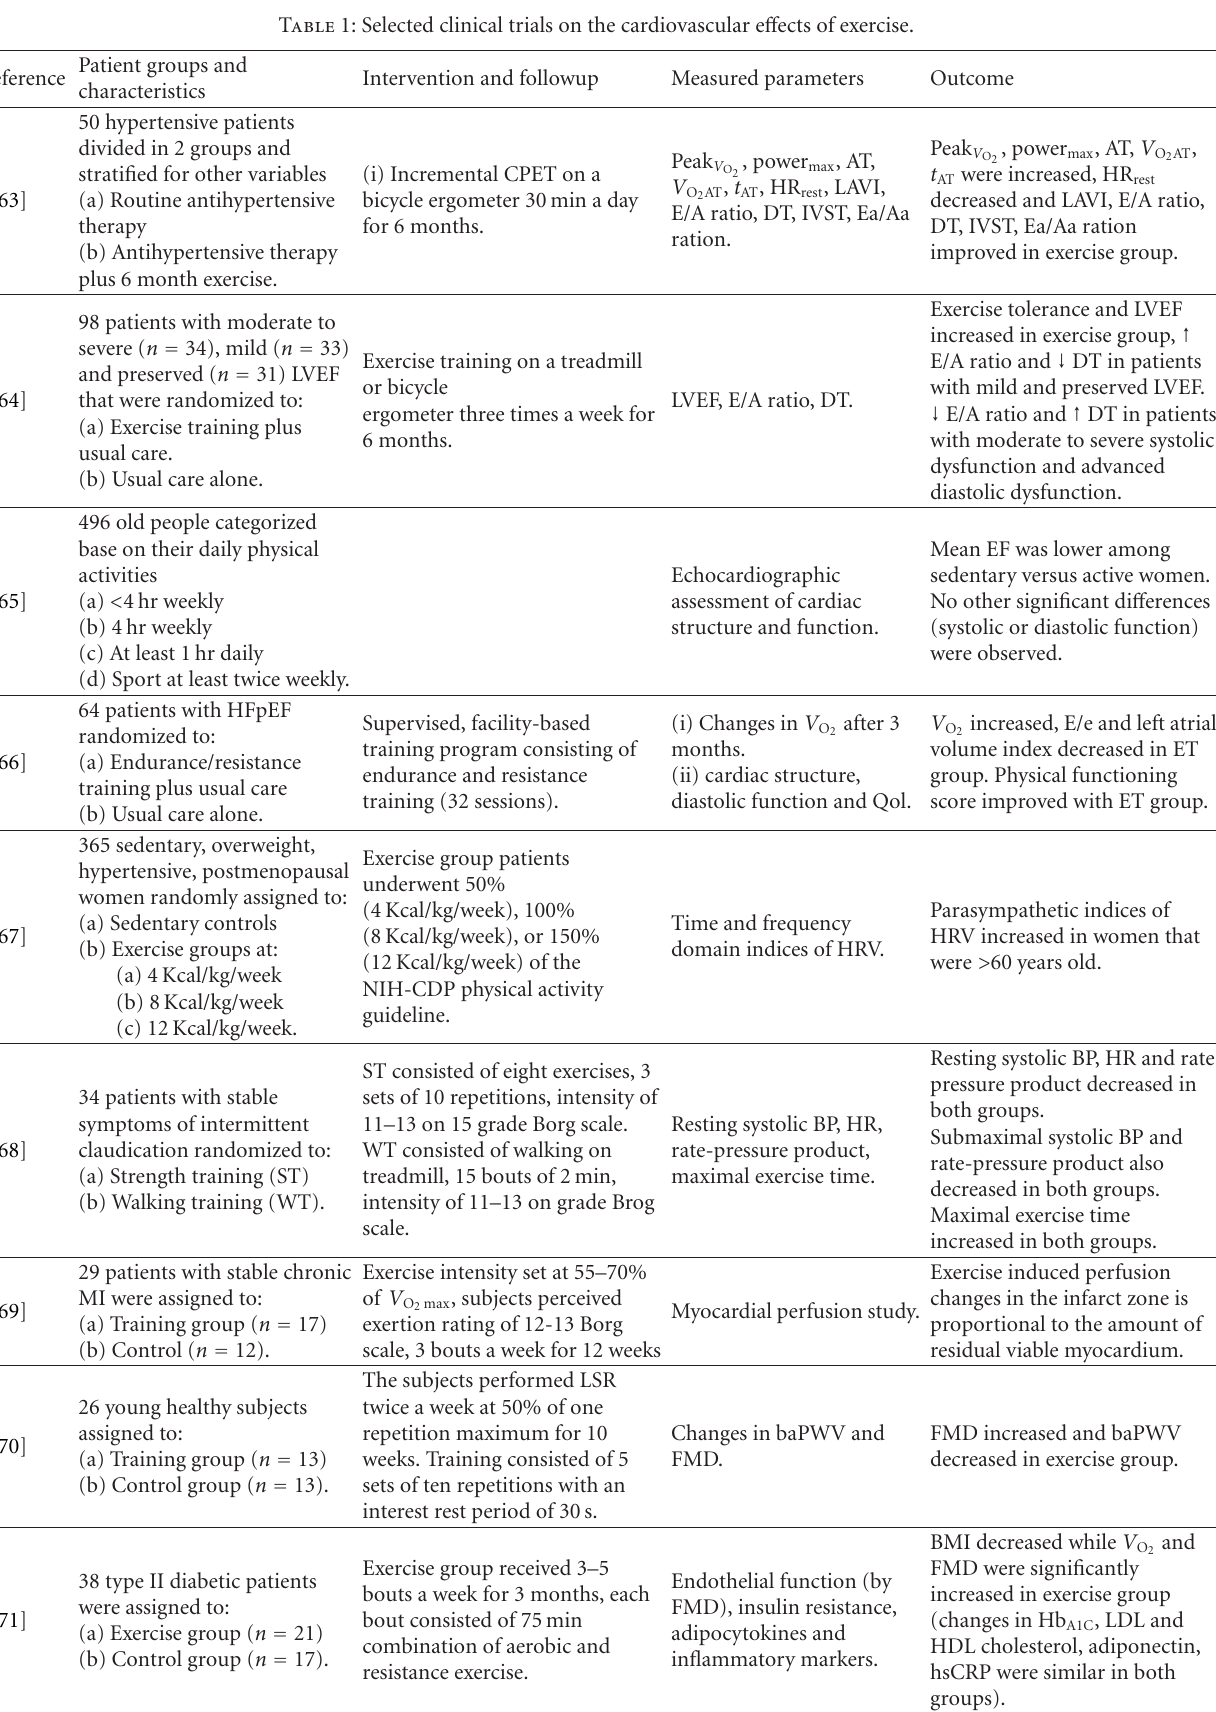
Table 1: Selected clinical trials on the cardiovascular e ff ects of